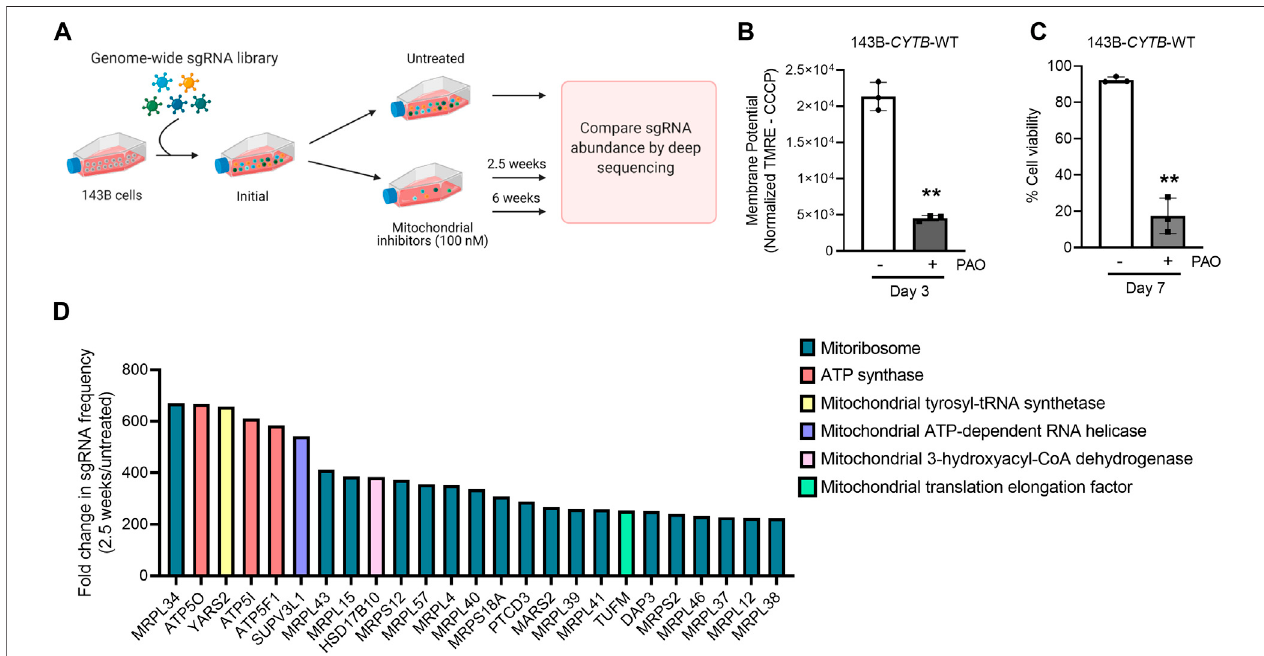
FIGURE1| SubunitsoftheATPsynthaseandthemitoribosomeareessentialtoinducecelldeathuponmitochondrialdysfunction. (A) Schematicrepresentationof the CRISPR-based positive selection screen. (B) Cells were treated with 100 nM pericidin A, antimycin A, and oligomycin for 3 days and mitochondrial membrane potentialwasmeasured.ThevaluerepresentstheMFIofTMREcorrectedwiththevaluefromthesamesampleafterCCCPtreatment. (C) Cellsweretreatedwith100 nM pericidin A, antimycin A, and oligomycin for 7 days and the percentage of cellular viability was assessed. (D) The gene scores for the top 25 genes following treatmentwithmitochondrialinhibitorsofcomplexesI,IIIandVfor2.5 weeks. MRPL34 , ATP5O and YARS2 arethethreebestscoringgenes.Panel1Awascreatedwith